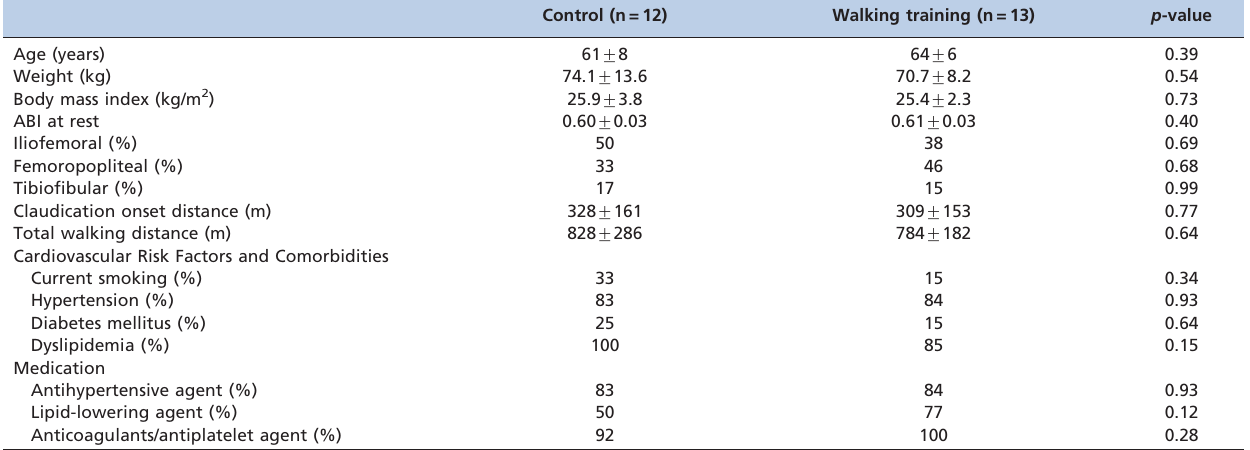
Table 1 - Clinical characteristics of the study patients.